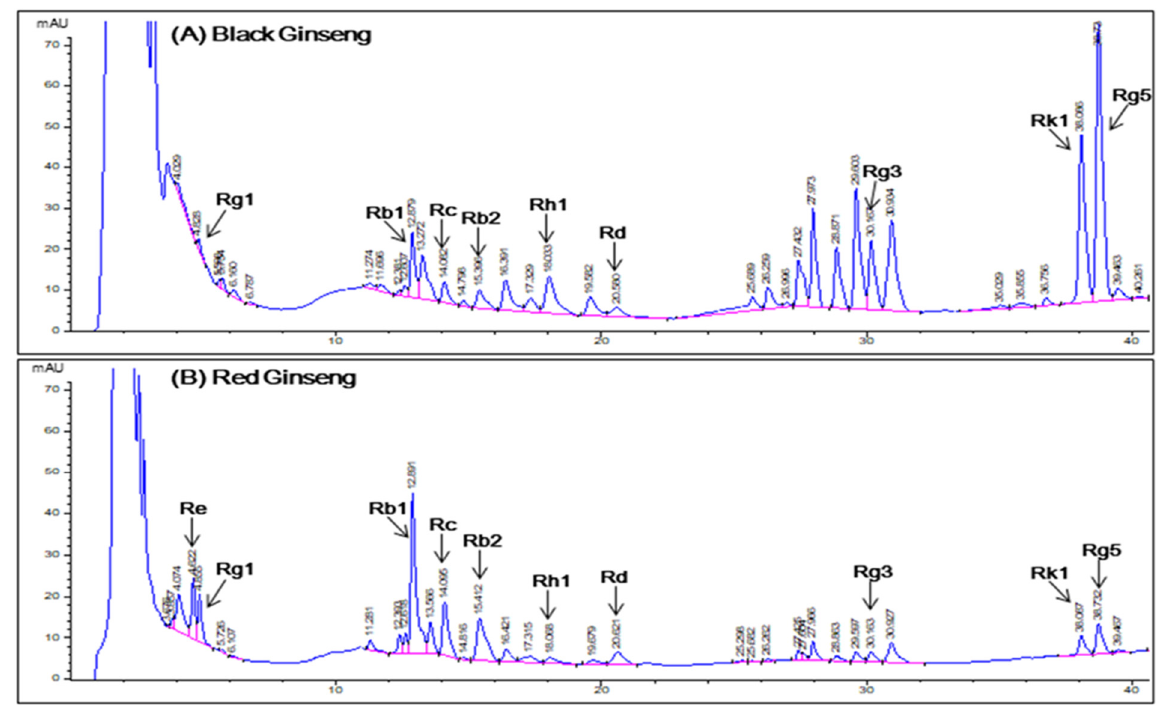
Figure 2. Chromatograms obtained from high-performance liquid chromatography analysis of ginsenosides in ( A ) black ginseng and ( B ) red ginseng extracts. Detection at a wavelength of 203 nm.